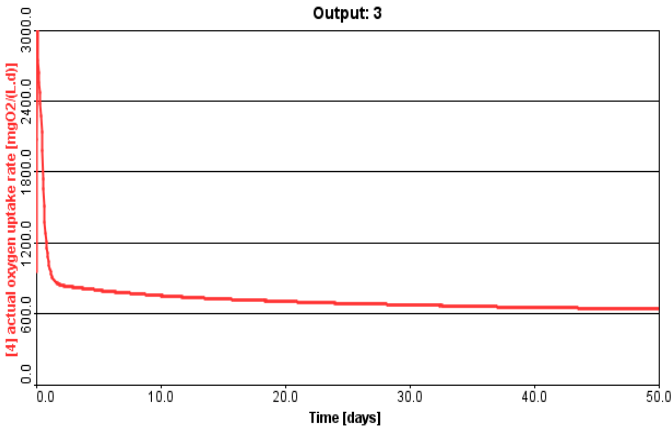
Figure 8. O 2 uptake rate data in the bio treatment unit for scenario